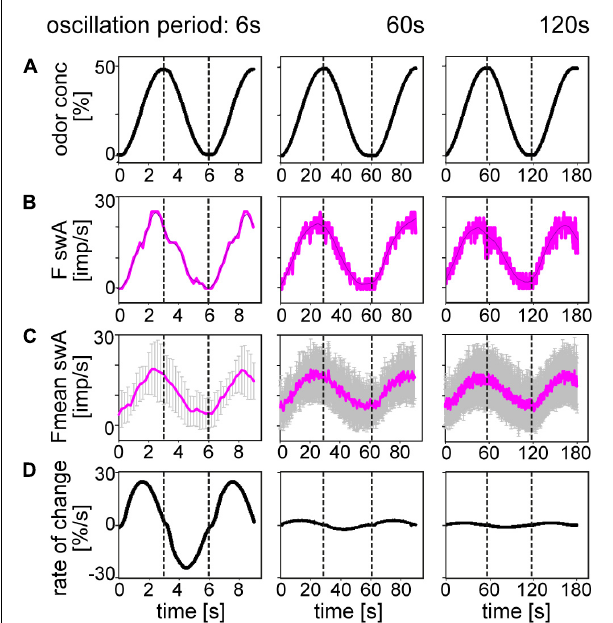
FIGURE 3 | Responses of the swA ORN to oscillating changes in odor concentration. (A) Time course of odor concentration for three different oscillation periods. (B) Time course of impulse frequency. Thin lines are calculated frequency curves smoothing out sharp changes in direction without shifting the maxima and minima values. (C) Time course of mean impulse frequency and standard deviations for 10 swA ORNs. (D) Time course of the rate of concentration change for the three oscillation periods. Different time scales were used to demonstrate the whole oscillation periods. Dotted vertical lines indicate the phase shift between time courses of odor concentration, impulse frequency and rate of concentration change.